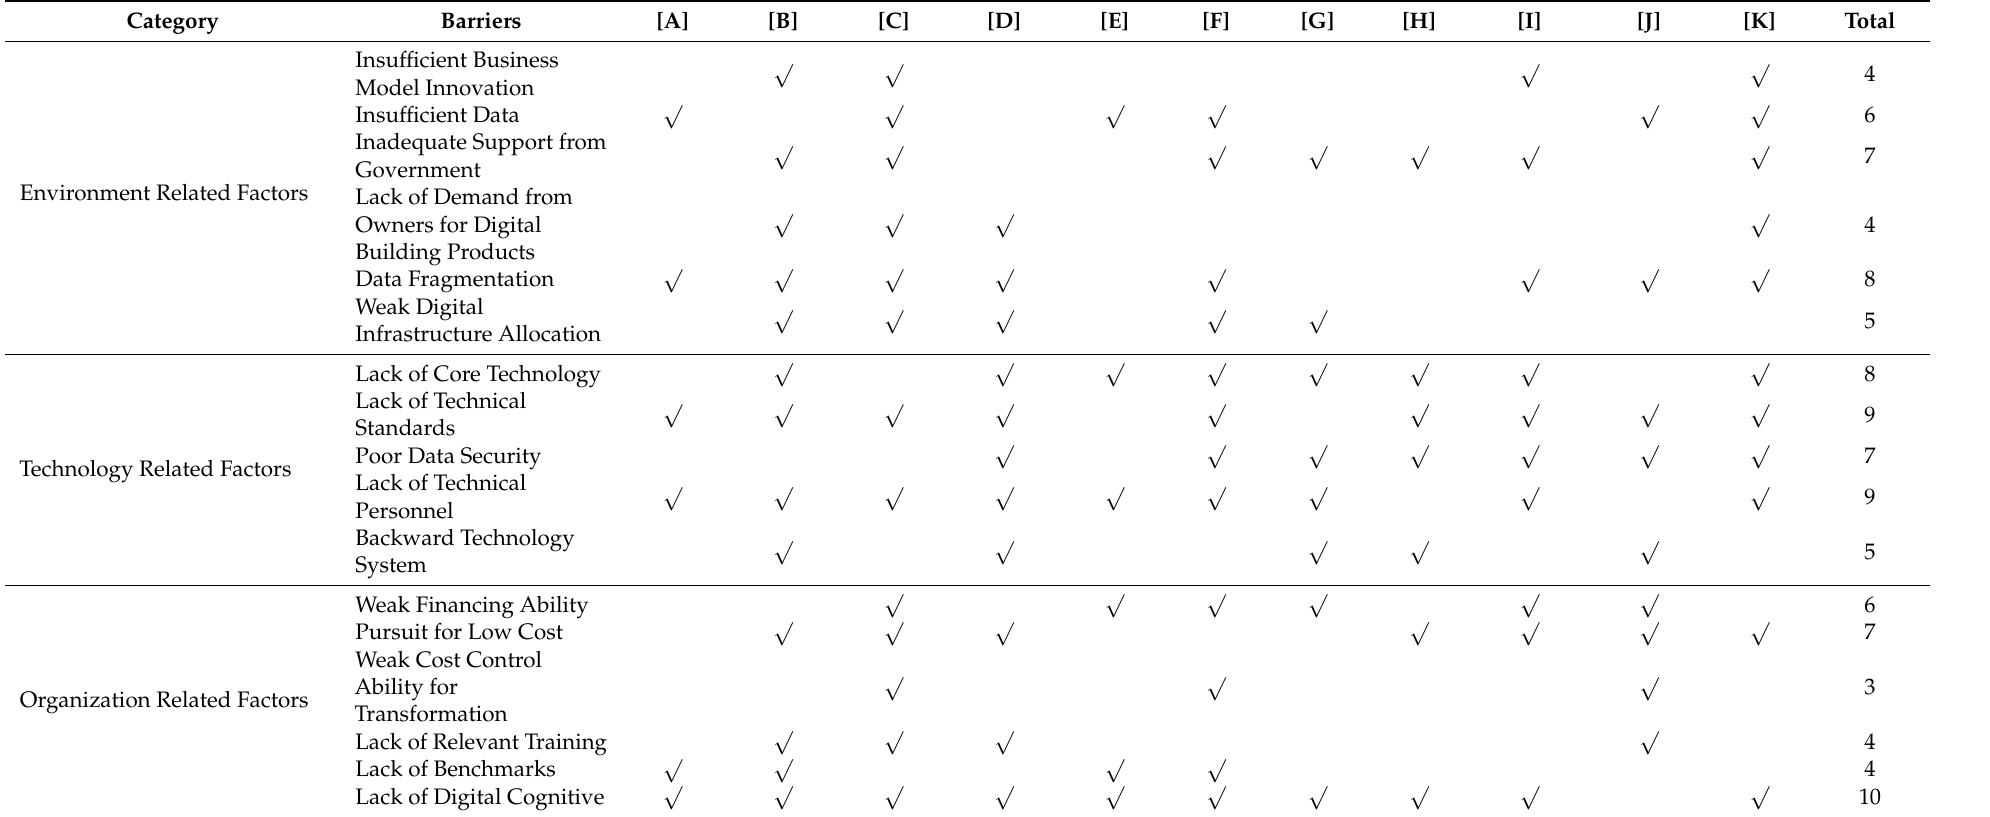
Table 2. Potential barriers to digital transformation in the Chinese construction